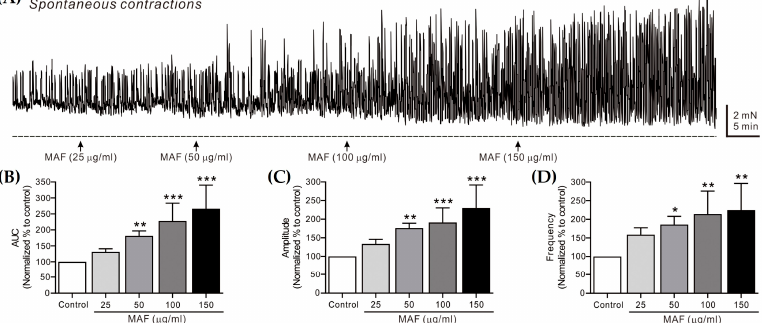
Figure 3. E ff ects of MAF on spontaneous contractions of smooth muscle strips in human sigmoid colon in situ. ( A ) Representative raw traces showing that MAF increased spontaneous contractions in a dose-dependent manner (25–150 µg/mL). Arrows indicate the points of MAF administration. Summarized graphs showing the e ff ects of MAF on ( B ) AUC, ( C ) amplitude, and ( D ) frequency of spontaneous contractions. Signi fi cant di ff erence (* p < 0.05, ** p < 0.01, and *** p < 0.001) compared with control. Table 1. Relative values of AUC, amplitude, and frequency (% of control) for spontaneous contrac- tions after treatment with each dose of MAF in human ileal and colonic smooth muscle strips in situ.